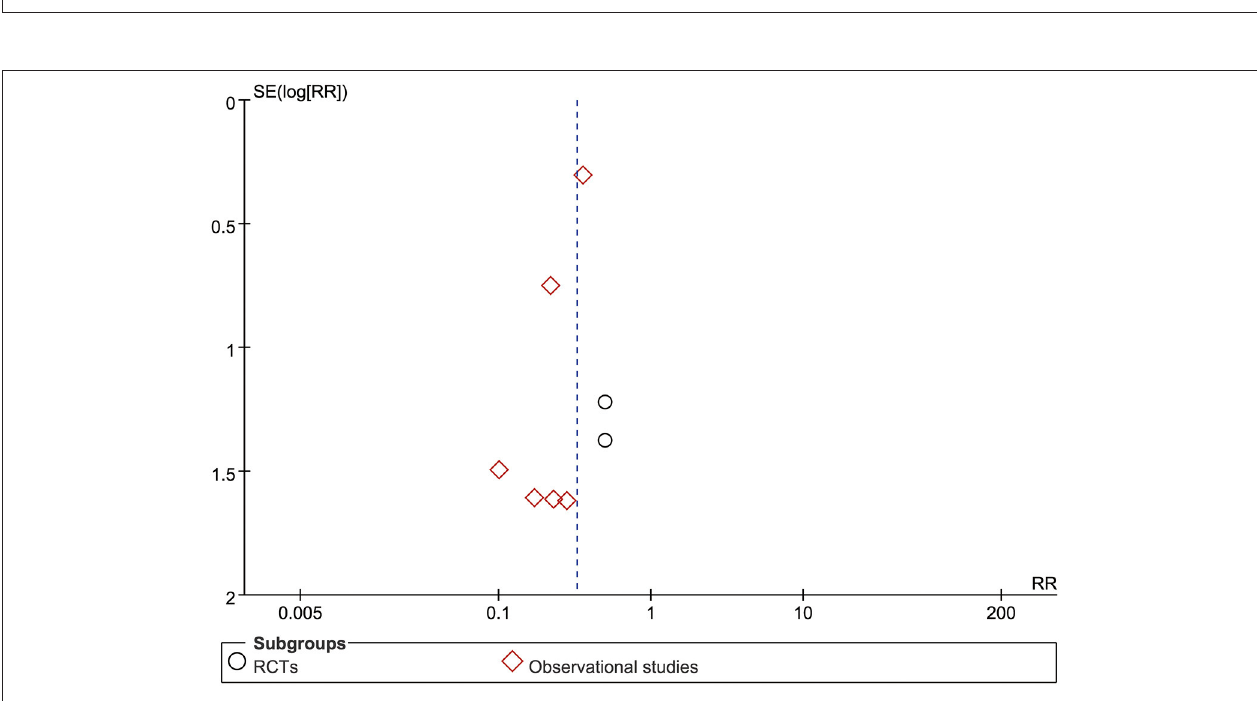
FIGURE 4 | The effect of Chinese herbal medicine as an adjuvant on side effects during COVID-19.